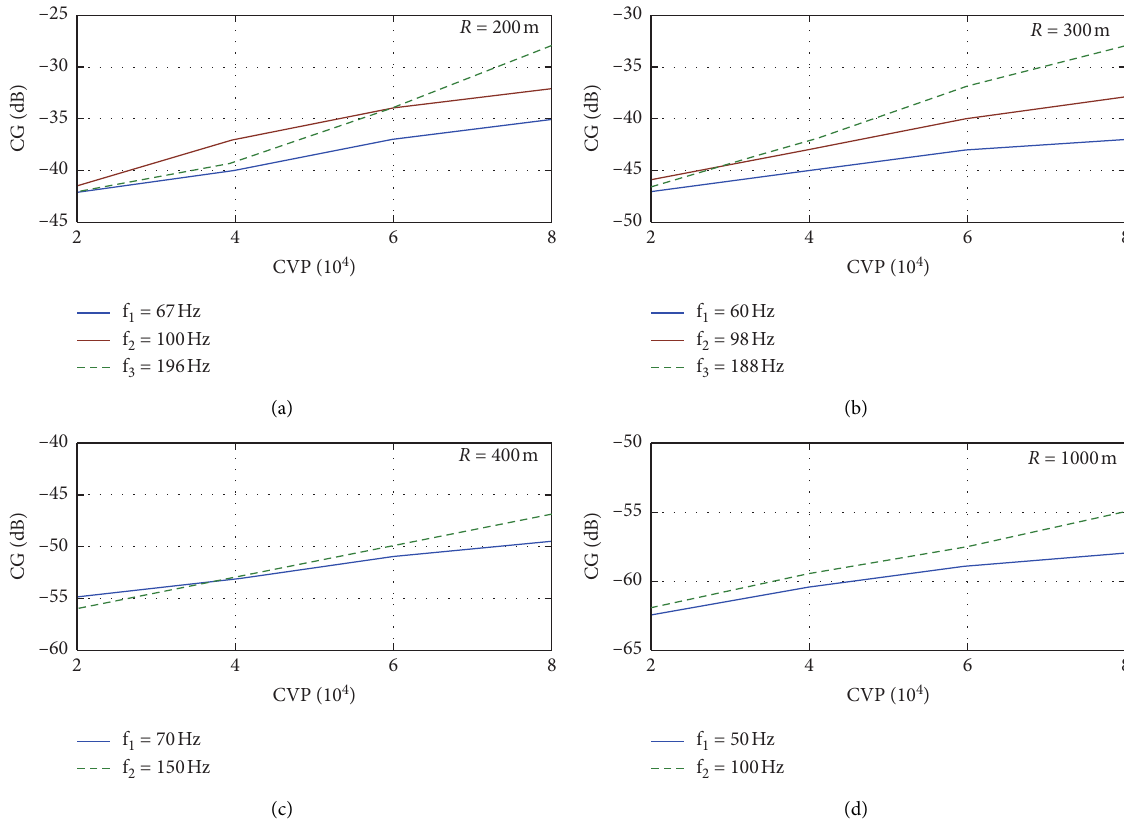
Figure 9: Comparison of corrugation grades on curved tracks with different radii (a), (b), (c), and (d).